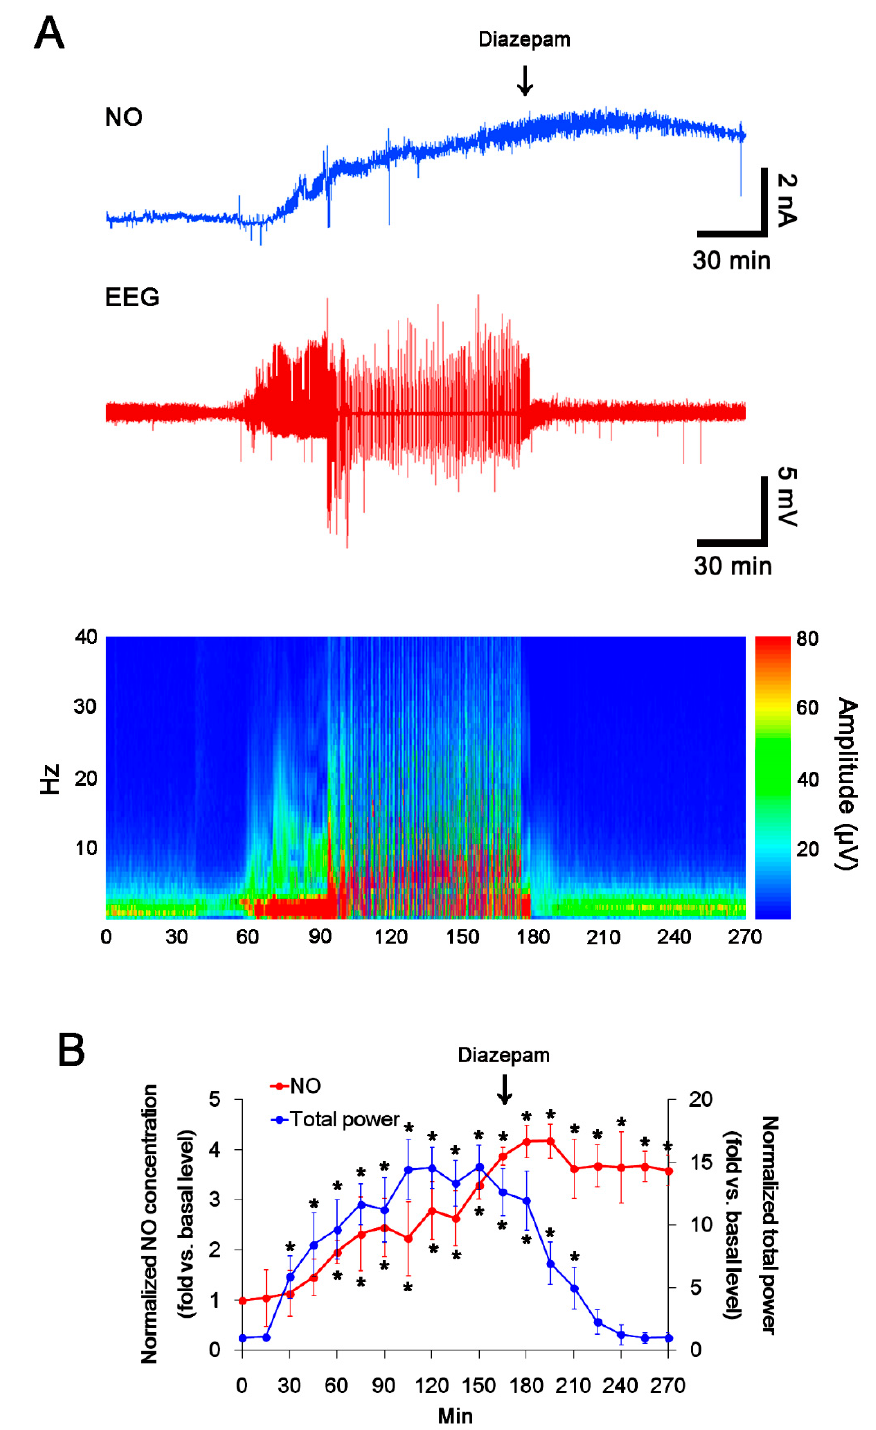
Figure 1. The real-time simultaneous monitoring of NO and EEG after PILO injection. NO level elevates after PILO injection and gradually increases during SE. Diazepam treatment recovers total EEG power to basal level, but not NO level. ( A ) Representative NO concentration (upper panel), EEG trace (middle panel) and frequency-power spectral temporal map (lower panel) in response to PILO. ( B ) Quantification of NO level and total EEG power in response to PILO (mean ± SEM; * p < 0.05 vs. basal level, repeated-measure one-way ANOVA; n = 7, respectively).